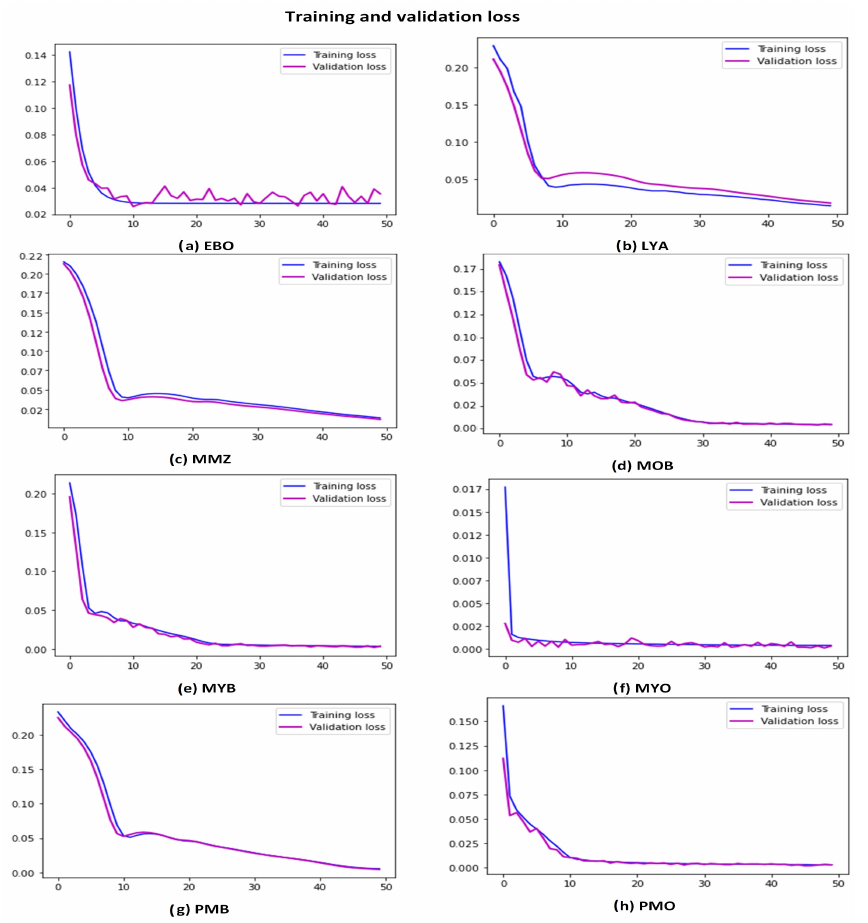
Figure 7. The DCAE model convergence based on training and validation